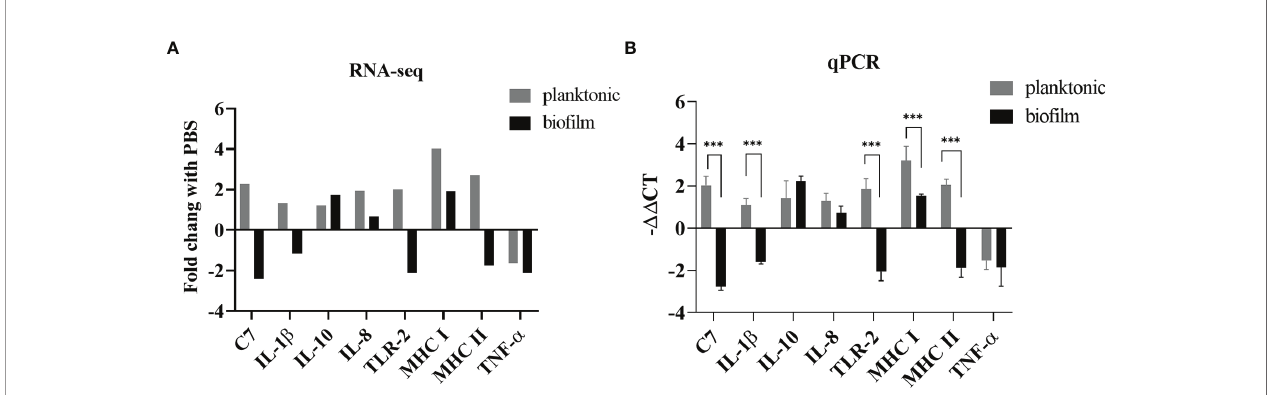
FIGURE 5 | Comparison of gene expression determined by RNA-seq and qPCR. (A) The relative expression levels from the RNA-seq analysis were compared with the PBS group. (B) The relative expression levels from the qPCR analysis were compared with the PBS group. p -values were calculated by two-way ANOVA ( p < 0.01 **, p < 0.001 ***). Each value is the mean of six samples. Bars represent mean ± standard